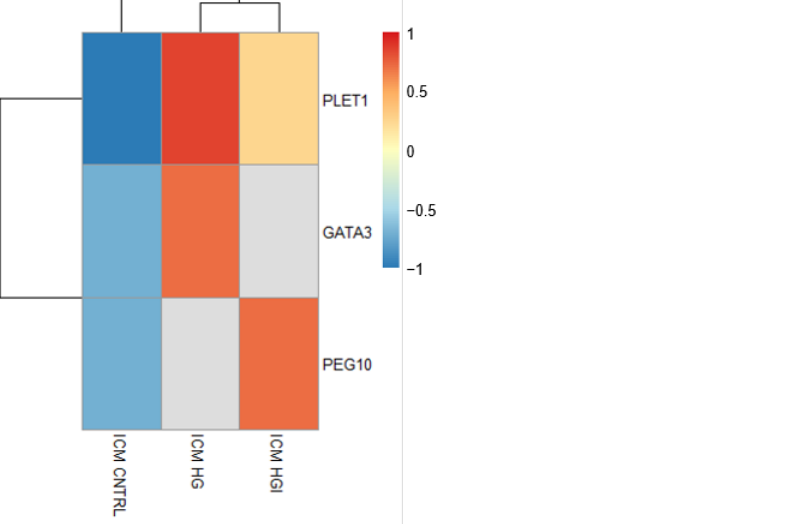
Figure 7. Heatmap showing the differential expression of genes (DEG) implicated in the TE lineage in HG and HGI ICM compared to CNTRL ICM. The mean normalized expression counts of n = 3 biological replicates, transformed to a Z-score, are represented by the color key. The gray color indicates the gene is not a DEG in that group. ICM, inner cell mass. TE, trophectoderm.